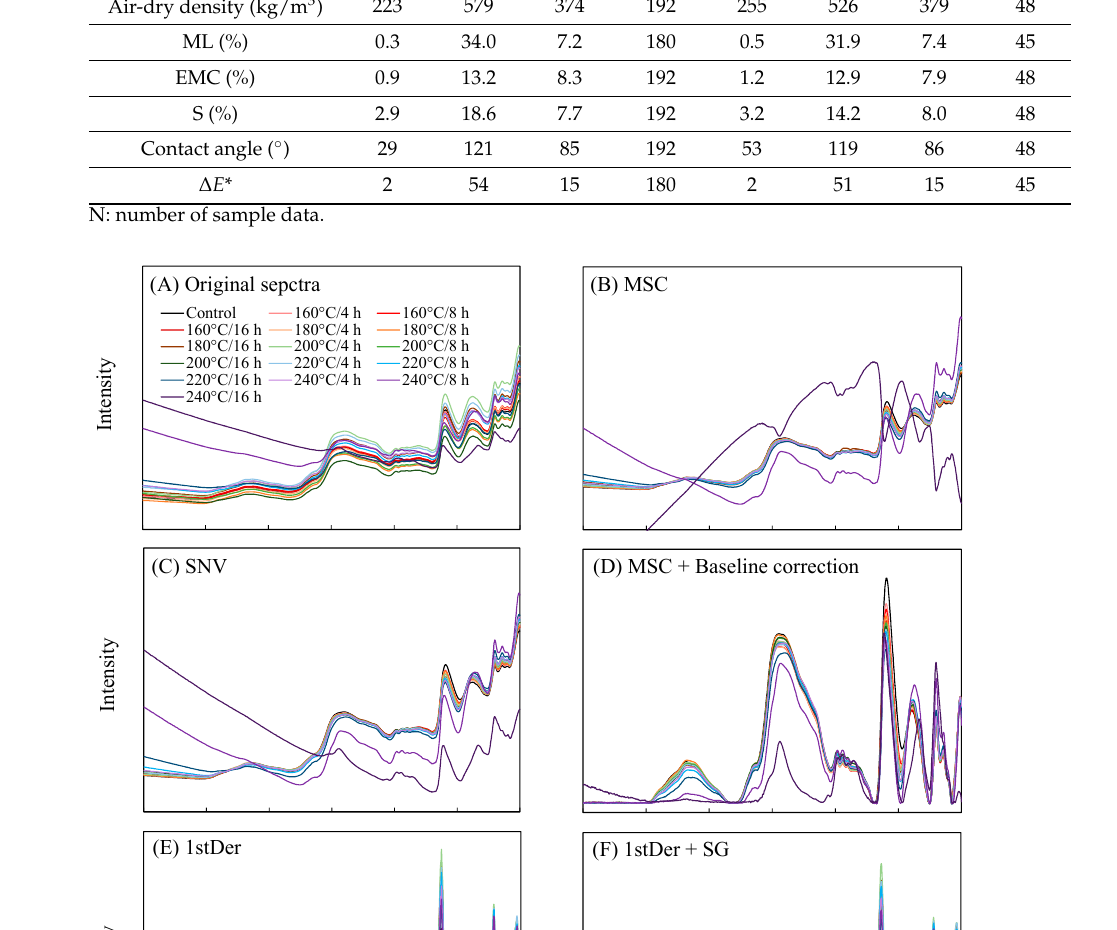
Table 2. The ranges of physical properties of calibration and prediction sets in NIRS analysis model. Calibration Data Properties